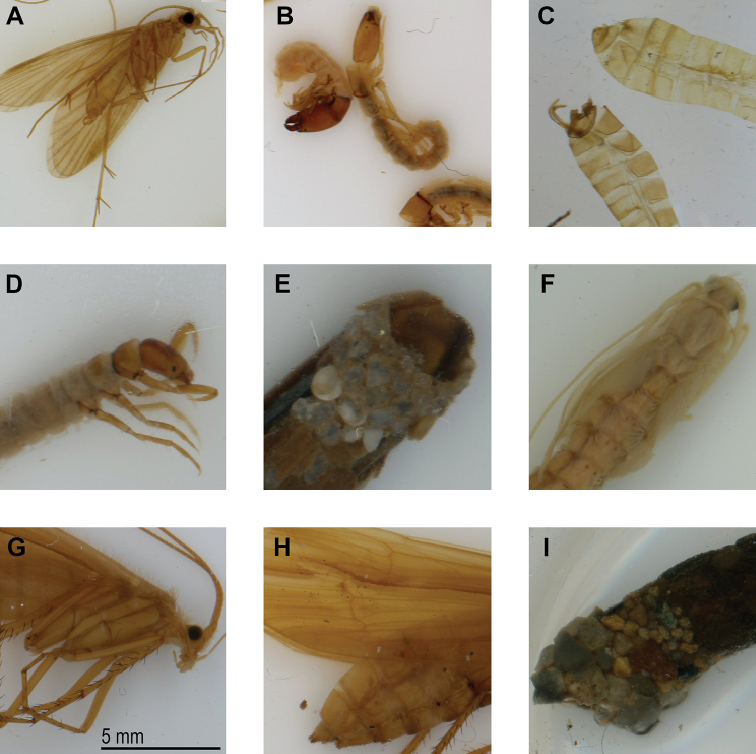
Example scans of different species and life stages of Essig Museum of Entomology Trichoptera showing detail of morphological features ADolophilodesnovusamericana (Ling, 1938) ♂, CA: Marin Co., EMEC 373433 BWormaldia sp. larvae, CA: Nevada Co., EMEC 1194742 CLimnephilusfrijole Ross, 1944 genitalic dissections of ♀♂, CA: Modoc Co., EMEC 373223 D larva and E case of Yphriacalifornica (Banks, 1907), CA: El Dorado Co., EMEC 373355 FLimnephilidae pupa, no location data, EMEC 373316 GPsychoglyphaormiae ♀ (Ross, 1938), CA: Nevada Co., EMEC 373259 HPsychoglypha sp. ♀, CA: Nevada Co., EMEC 373266 and IHesperophylaxdesignatus (Walker, 1852) case, CA: Mono Co., EMEC 373246. All scans are unmodified in software (no sharpening, white balance, or color correction). Scale bar: 5mm.